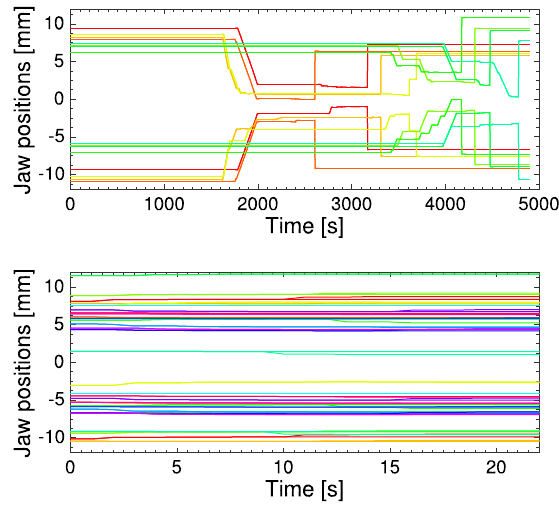
FIG. 5. Time required to align the 8 TCTs in IR1 and IR5 in 2012 with the BLM-based technique (top) and all 16 TCTPs in 2015 with the BPM-based technique (bottom). Each pair of jaws is marked in a separate color.